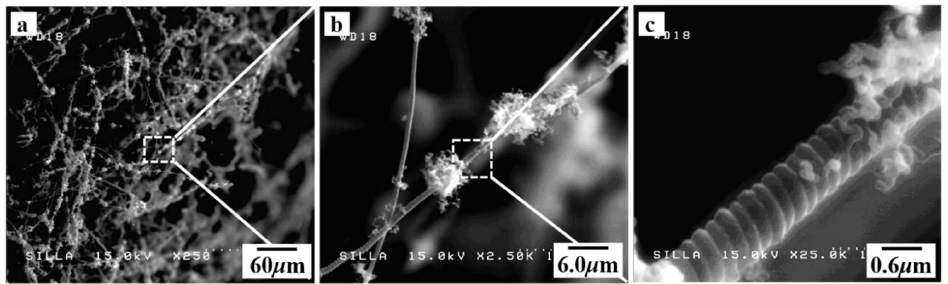
Figure 2. ( a ) The FESEM image of the surface morphology for sample J, ( b ) the magnified-FESEM image of the squared-area in ( a ), and ( c ) the high magnified-FESEM image of the squared-area in ( b ).